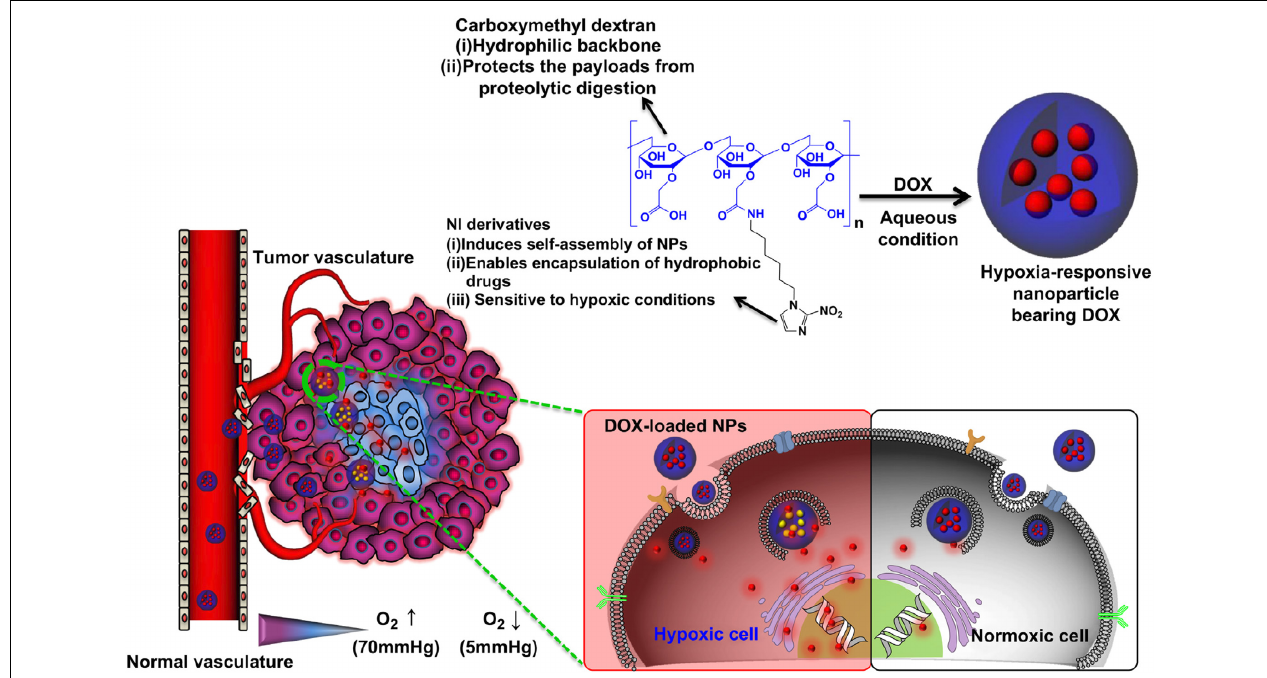
FIGURE 6 | Schematic illustration of a drug-loaded hypoxia-responsive polymer nanoparticle. The hypoxia-responsive polymers can reach the tumor site via the EPR effect, followed by intracellular drug release at hypoxic tissue. Reprinted from Thavasyappan Thambi, V.G. Deepagan, Hong Yeol Yoon, et al. Hypoxia-responsive polymeric nanoparticles for tumor-targeted drug delivery. Biomaterials. 2014;35(5):1735–43. With permission from reference (Thambi et al., 2014). NPs, nanoparticles; EPR, enhanced permeation and retention; DOX, doxorubicin.